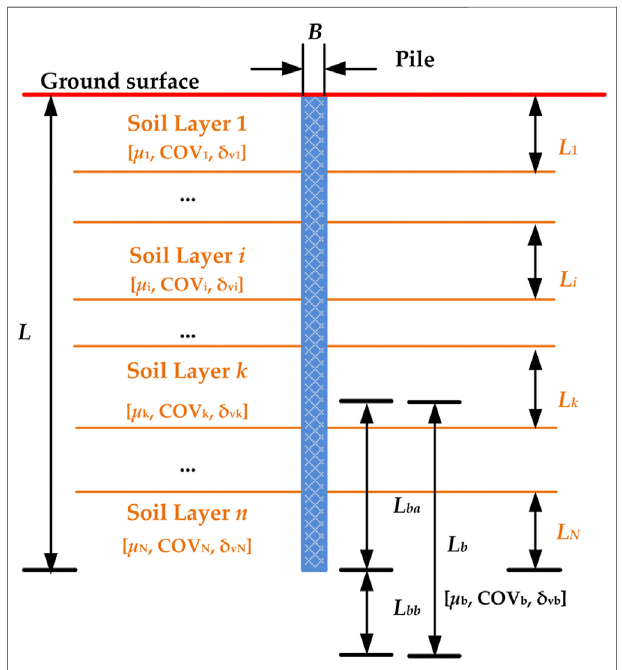
FIGURE 2 | Random fi eld model for layered soils.